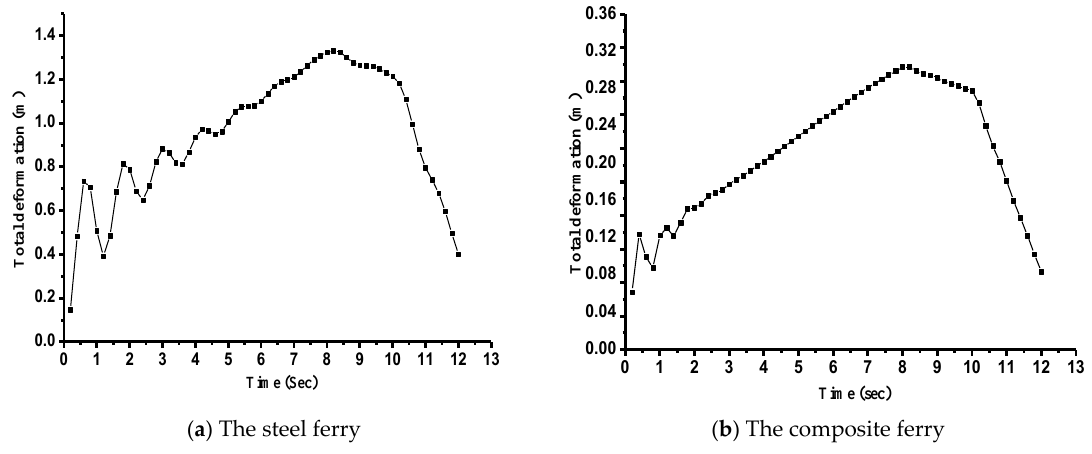
Figure 32. The total deformations with time for case 4.